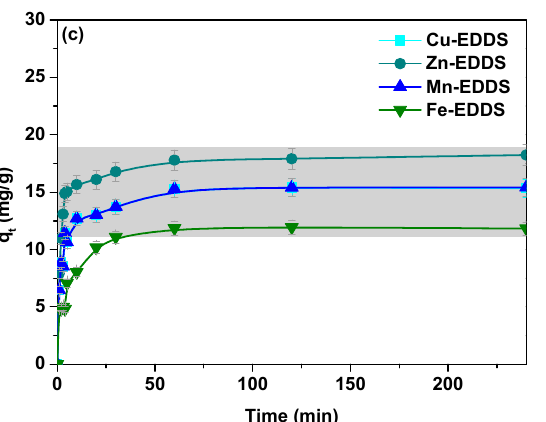
Figure 3. Effect of the phase contact time on the sorption capacity for the Cu(II), Zn(II), Mn(II) and Fe(III) complexes with EDDS on ( a )THA, ( b ) ZH and ( c ) AH.